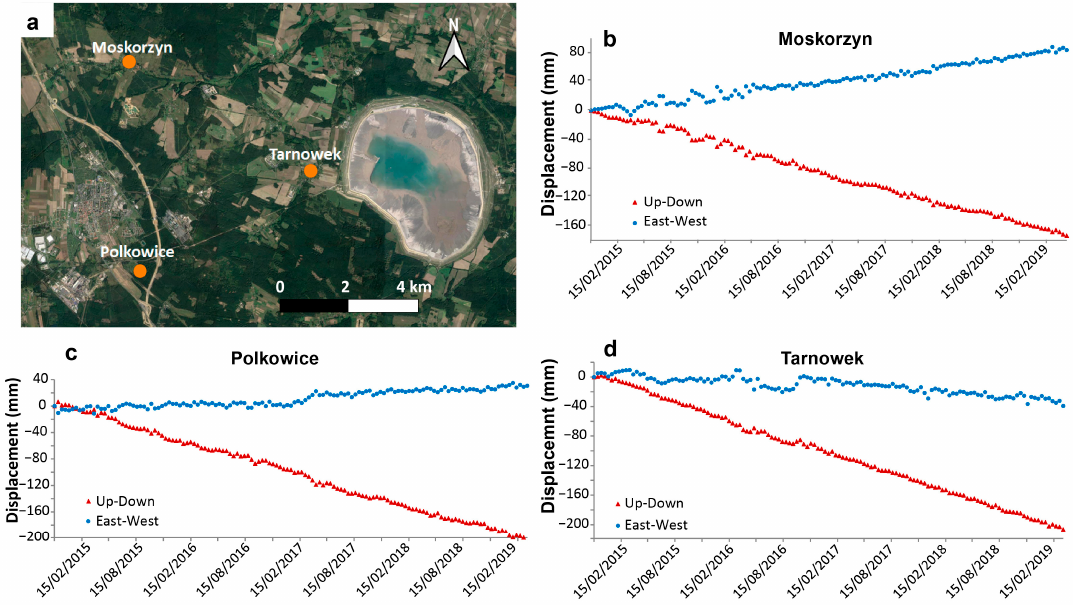
Figure 4. Time series of displacement for 3 areas selected as examples in the LGCD district; ( a ) location of the PSs selected for processing the time series; ( b – d ) time series at Moskorzyn, Polkowice, and Tarnowek towns, respectively; the time series were retrieved averaging the time series for 3 neighboring